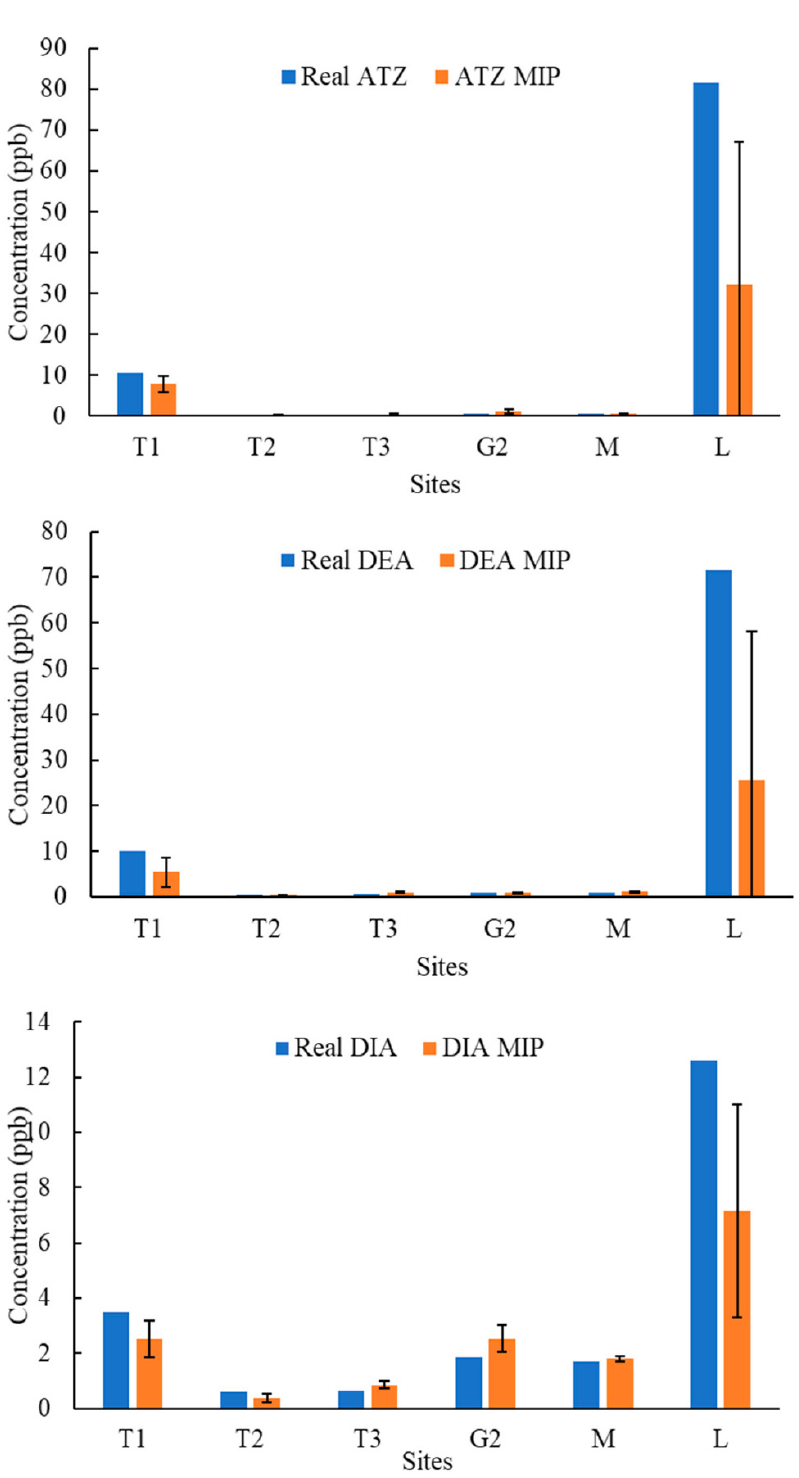
Figure 7. Average response of MIPs to ATZ, DEA, and DIA compared to real concentrations validated by LCMS/MS for samples of 11 August 2020.